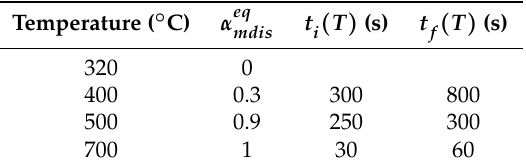
Table 5. Dissolved martensite fraction at equilibrium and initial and final times ti ( T ), tf ( T ) of martensite dissolution with initial and final normalized fractions: Xi = 0.3, Xf = 0.9. Data calibrated for the simulation of SLM production of samples S3 and S5.